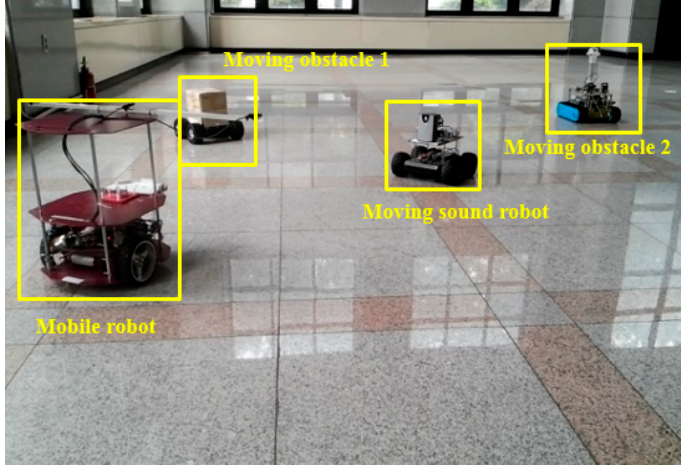
Figure 17. Experimental environment for multiple moving obstacle avoidance. The sizes of the moving obstacles were 80 (W) × 30 (H) × 50 (D) mm for Obstacle 1 and 50 (W) × 25 (H) × 20 (D) mm for Obstacle 2.